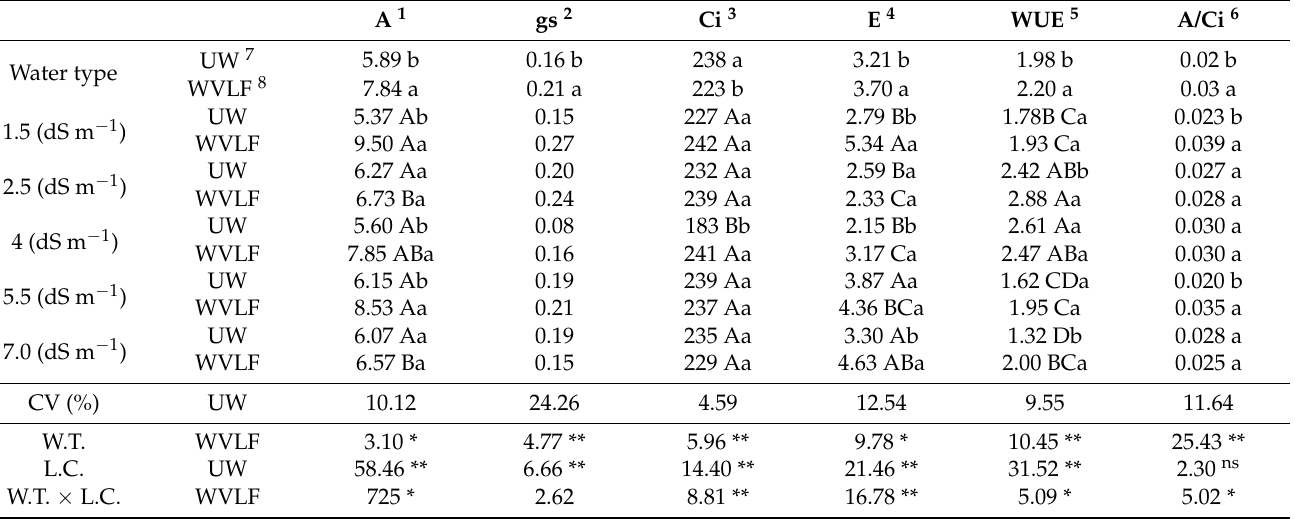
Table 1. Gas exchange of tomato crop subjected to different levels of conductivity and water types. A